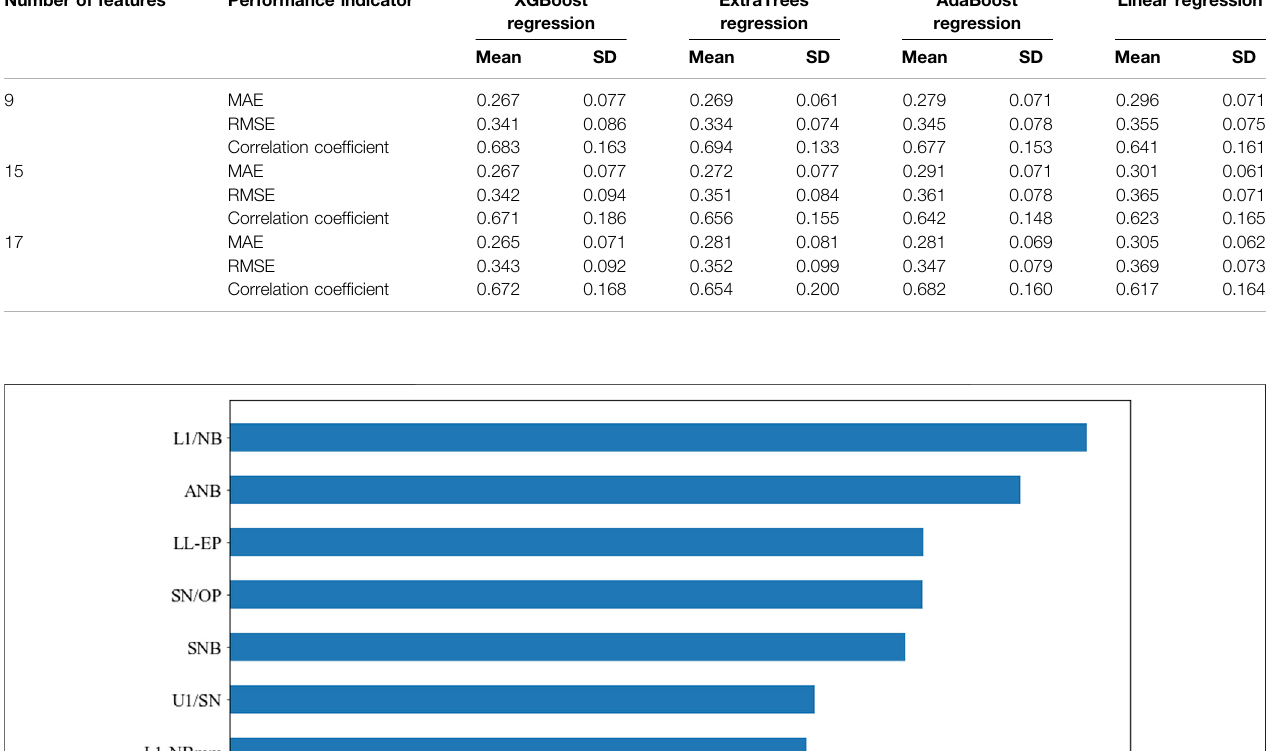
Frontiers in Physiology |